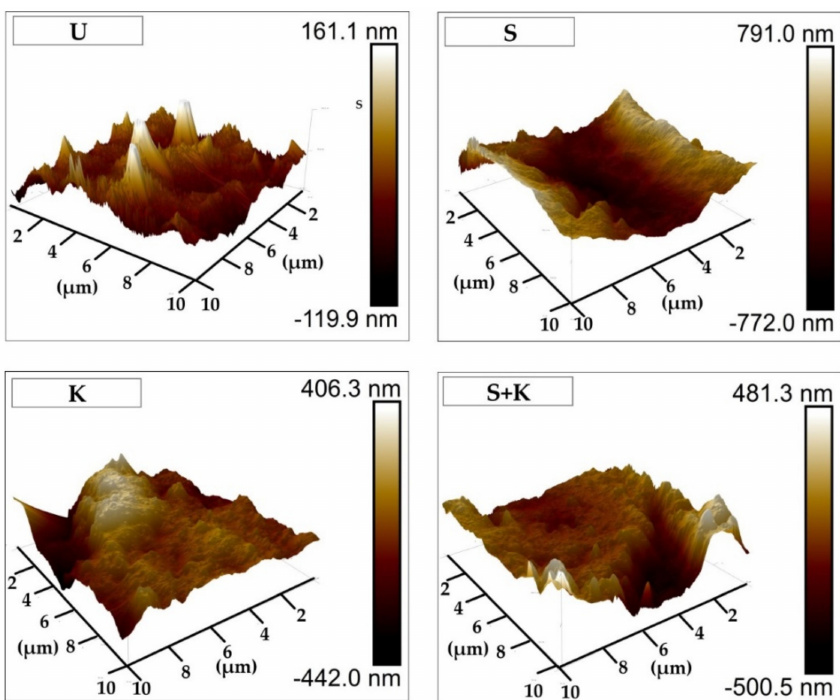
Figure 6. Atomic force microscopy (AFM) images representing roughness of the stainless steel surfaces treated by di ff erent cleaning procedures. The applied cleaning procedure is indicated by the abbreviation in the upper left corner of each figure (U – ultrasonic cleaning, K – chemical etching with Kroll’s reagent, S – sandblasting, S + K – sandblasting + chemical etching with Kroll’s reagent).